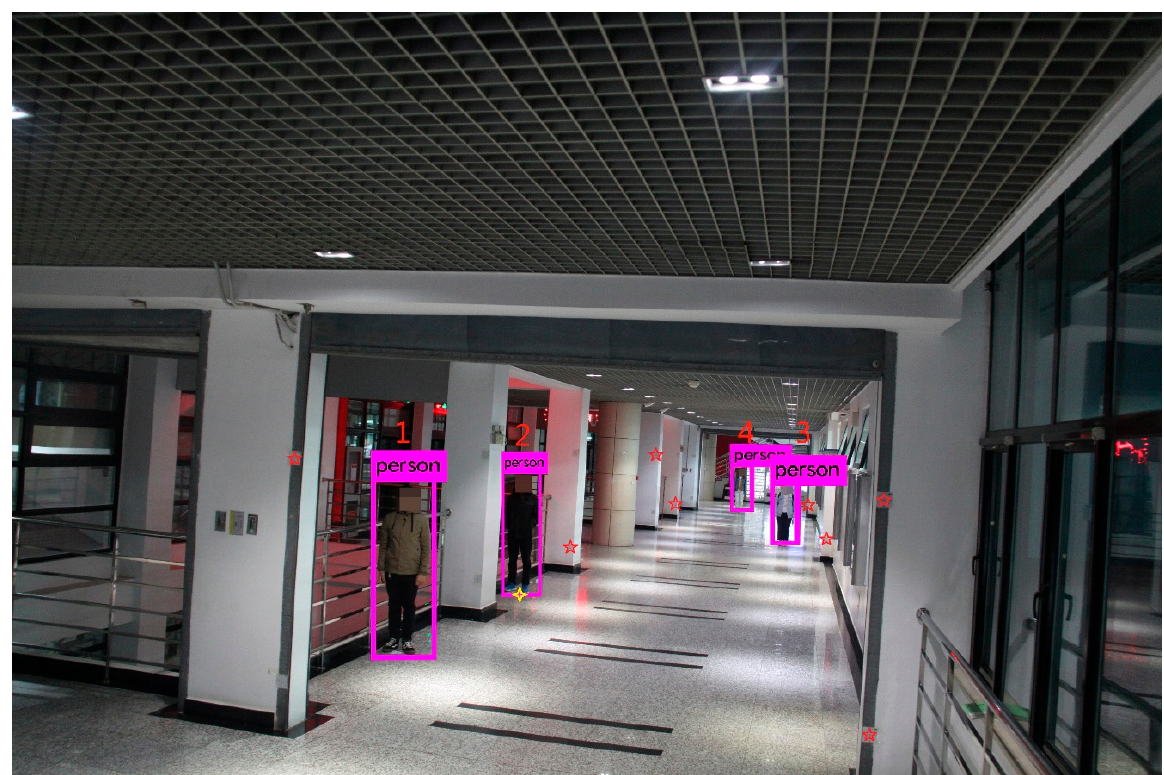
Figure 3. Scene 1 in CUMTB-Campus.